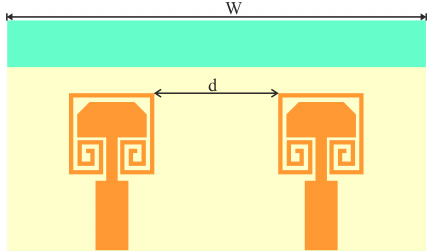
Figure 6. MIMO configuration-I Layout.